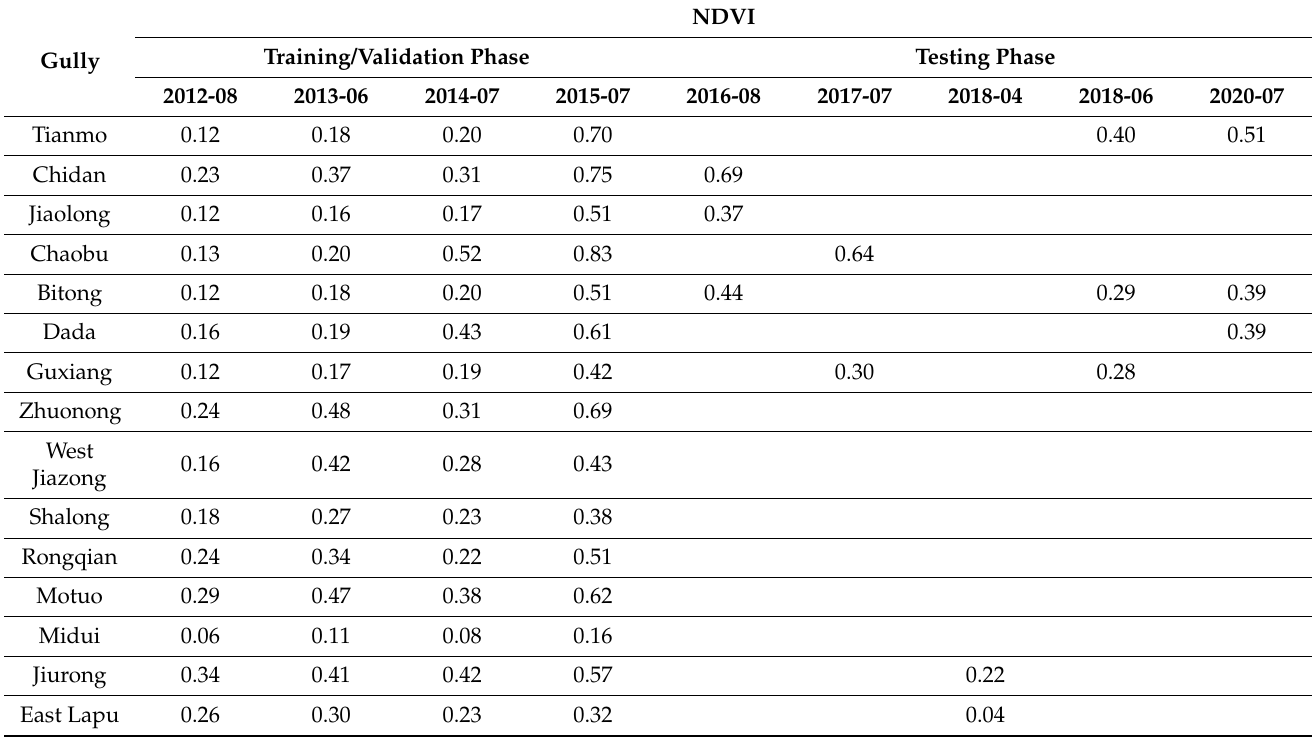
Table 6. NDVI changes of 15 debris flow gullies in the study area from 2012 to 2020.